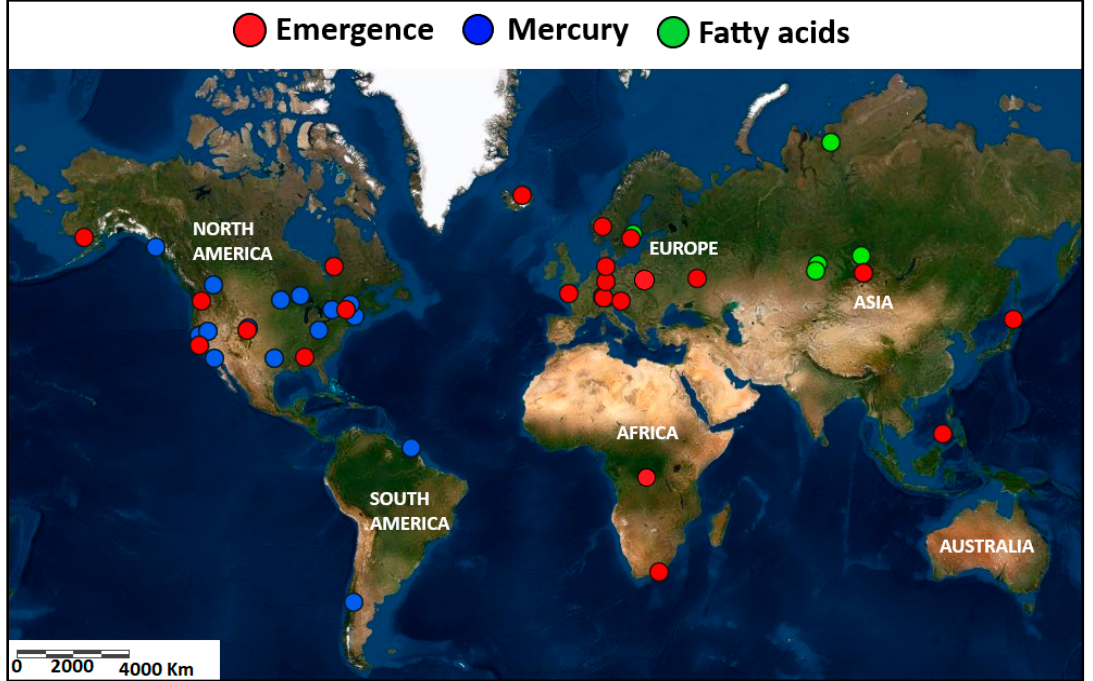
Figure 1. Map showing locality of studies documenting the emergence fatty acids and mercury content in six continents. Table 1. Insect emergence from lakes (g DM m − 2 year − 1 ) for available continents. ‘Community’ denotes instances where whole taxa values are reported. Average and coe ffi cient of variation in bold represents the grand average that was used to calculate emergence for Africa, South America, Asia, Australia.